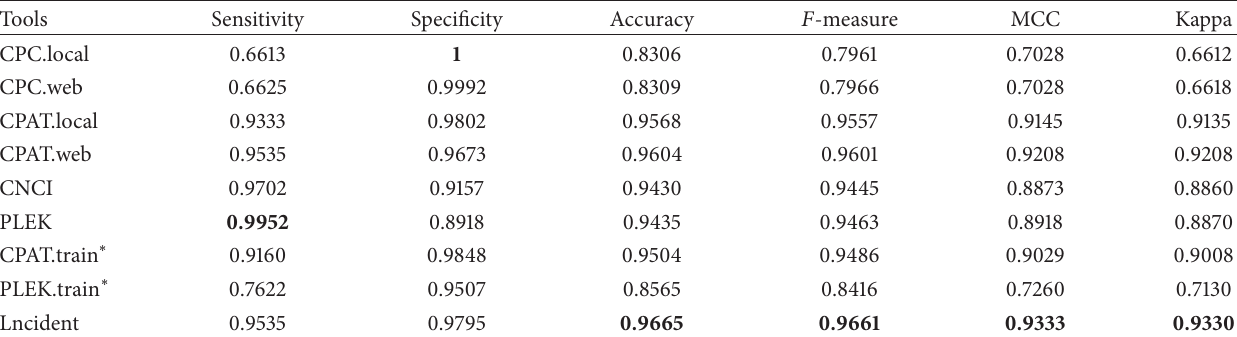
Table 1: The performances on human dataset 2.